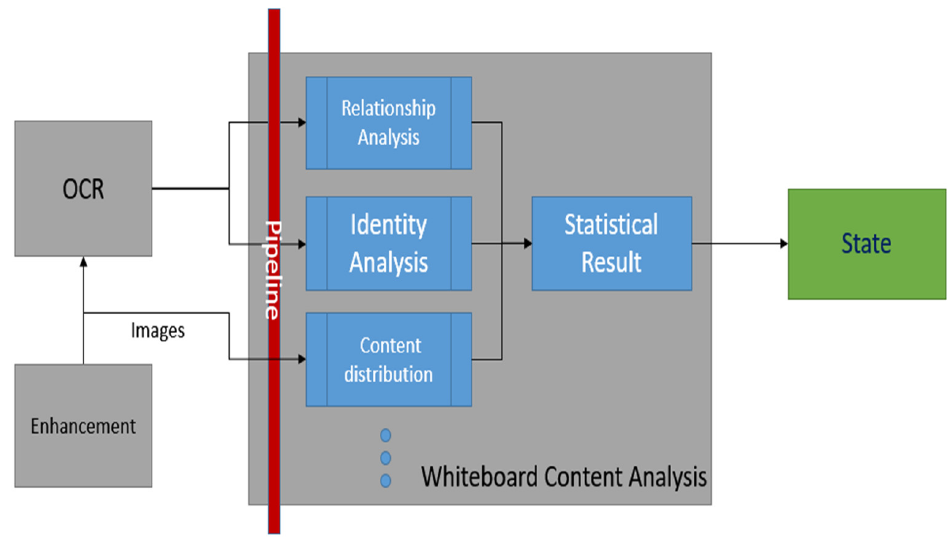
Figure 8. Whiteboard picture conversion text statistics for teaching status result flow chart.